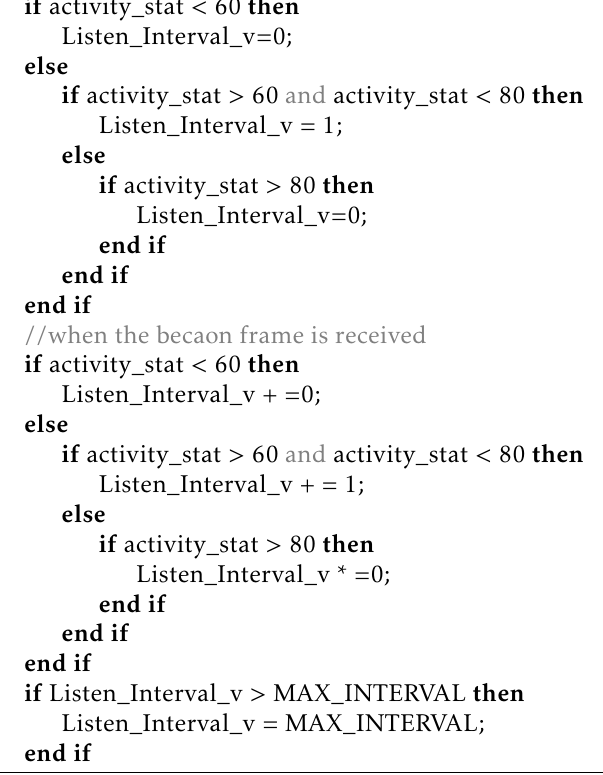
based on RSSI-awareness was put forward for Wi- Fi network. This mechanism was able to determine whether the current Wi-Fi RSSI was good, weak or bad, and to identify delayed-transmit packets for di ff erent intervals. For the underlying implementation, based on the decision tree and combination with the original IEEE 802.11 Power Save mechanism, mainly three parameters (Listen Interval, Timeout, TX delay) of Wi-Fi components were adjusted to achieve delayed transmission. • Listen Interval The listen interval parameter specifies a number of beacon intervals. These intervals can pass from a time that a beacon frame is listened by the wireless client device from the access point before a next beacon frame is listened (shown in Fig. 9). The value of listen interval defined in WL1271 chipset ranges from 0 to 255 and can be configured through the Wi-Fi driver interface. With the good signal strength, in order to improve the response capability of the application, the listen Interval was set to a small value. With the weak signal strength, the listen interval was properly increased linearly. Similarly, listen interval was adjusted in more aggressive growth for bad signal strength exponentially. Algorithm 1 Listen_interval control